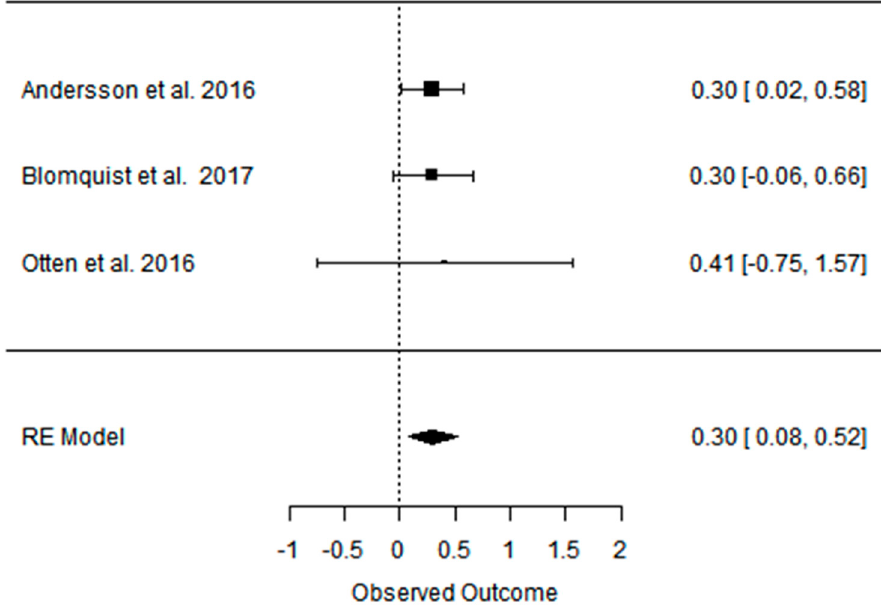
Figure A54. Forest plot of the effect of a CD on HOMA-IR in the long term (weighted mean difference).